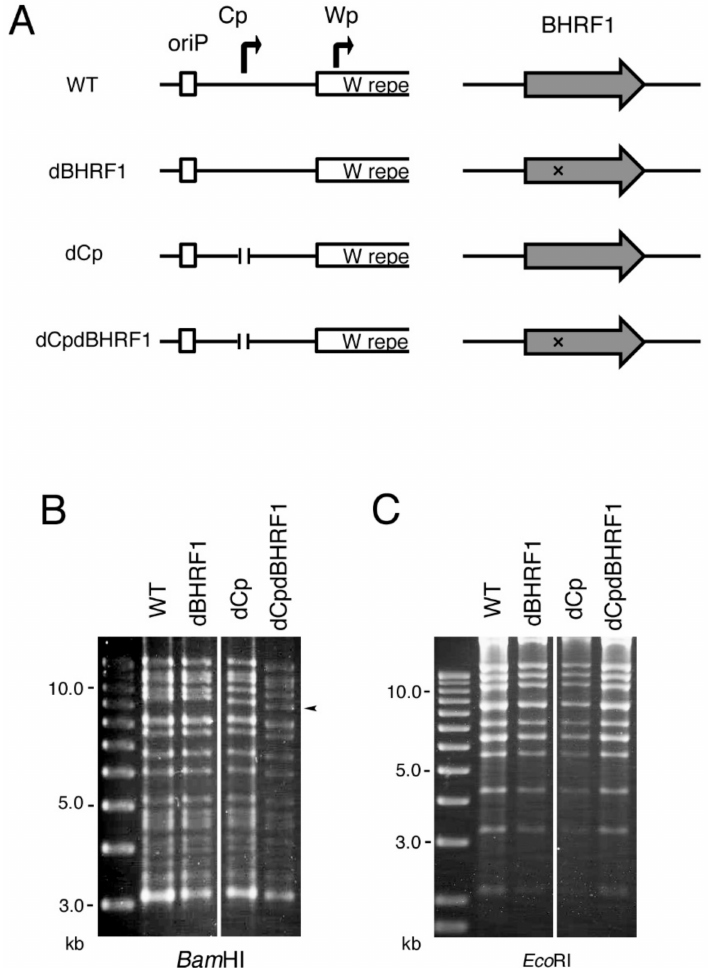
Figure 8. Construction of the BHRF1 deficient (dBHRF1) and Cp/BHRF1 double knockout (dCPdBHRF1) EBV mutants using the EBV-BAC system. ( A ) Schematic diagram of the EBV-BAC recombinant viruses. Two adenine residues were inserted between nucleotide 194 and 195 of BHRF1 amino acids to make a stop codon (T 194 AA). ( B , C ) Recombinant EBV-BAC DNA was digested by BamHI and EcoRI, and the products were examined by agarose gel